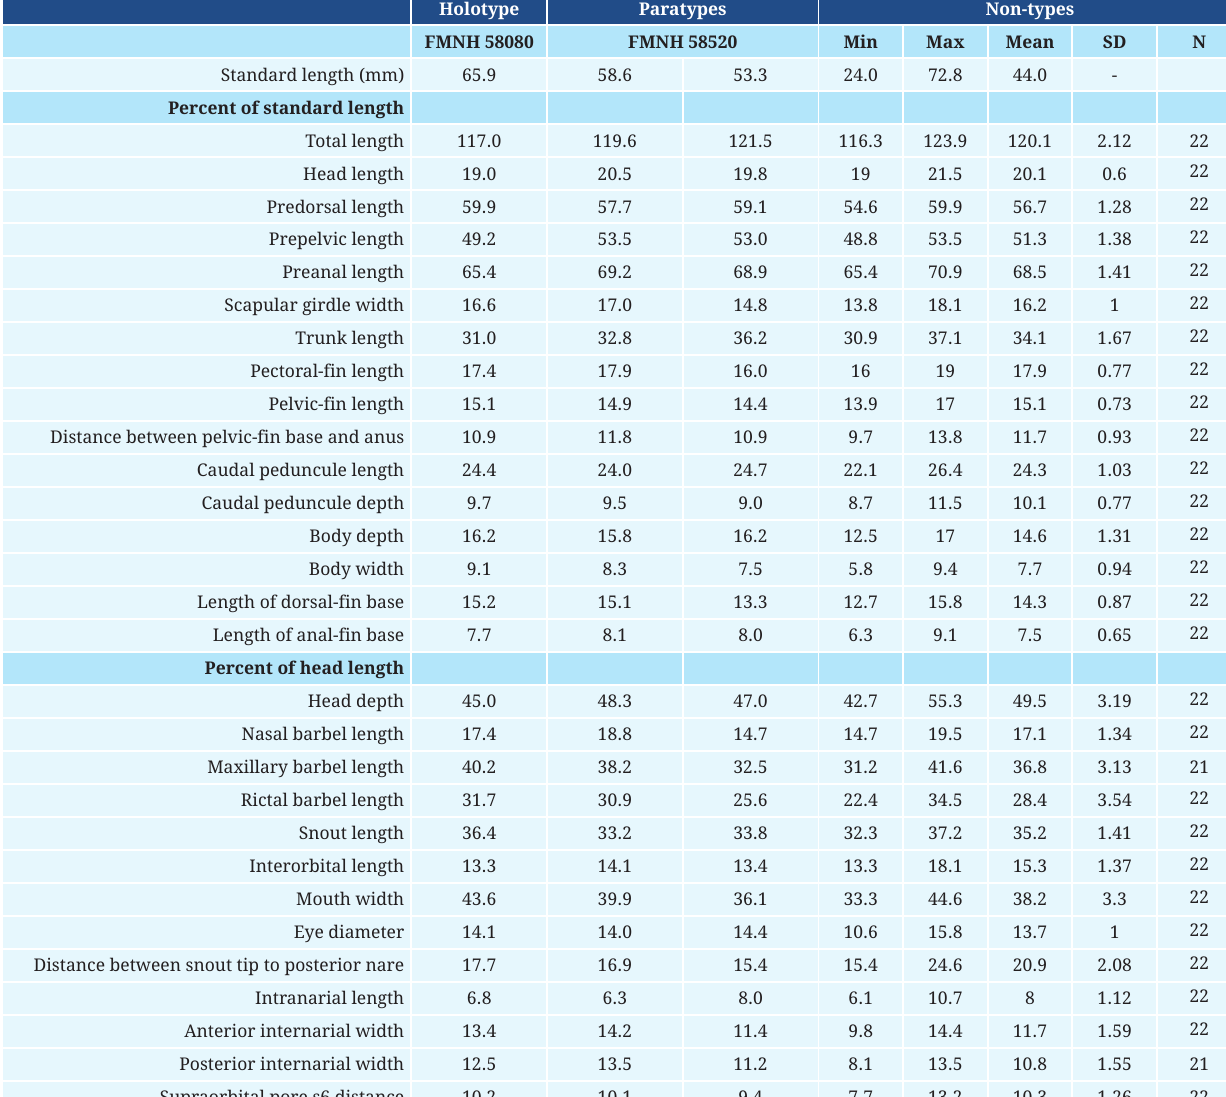
TABLE 9 | Morphometric data of Scleronema operculatum (data of type specimens not included in the range of non-types). N = number of non- types; SD = standard